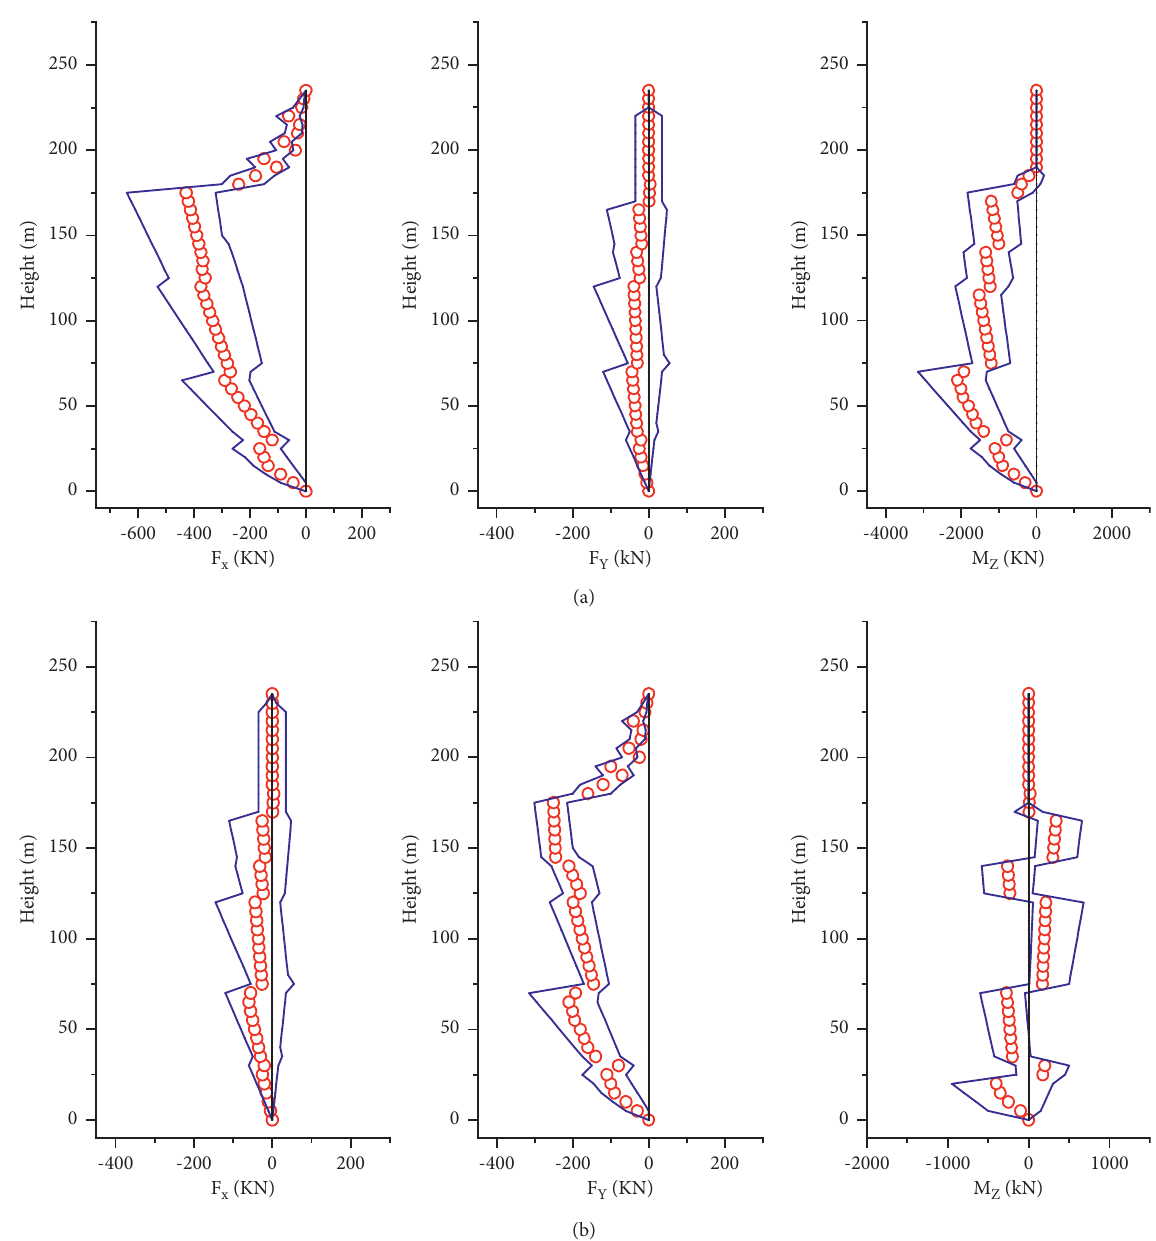
Figure 8: Distributions of mean, maximum, and minimum wind forces along the tower. (a) 0 ° wind direction, (b) − 90-degree wind